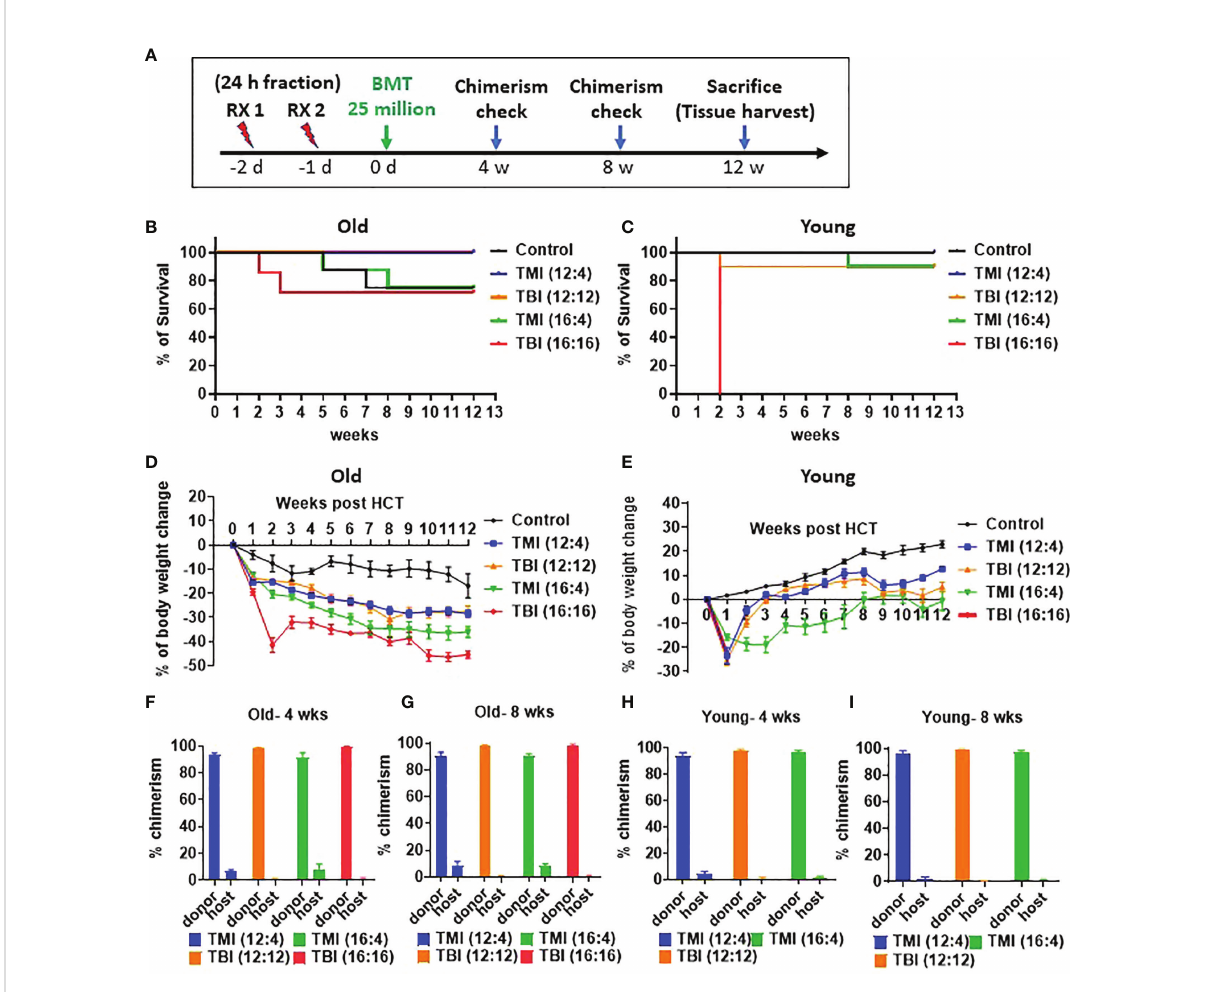
FIGURE 2 Comparison of TMI vs. TBI in survival, and donor engraftment in old and young mice. (A) Experiment schema. A total of 25 million of whole bone marrow cells were injected at 1 day intravenously after 2 times irradiation. (B) Survival rate of old mice for 12 weeks after BMT (Old control, n=8; TMI (12:4), n=10; TBI (12:12), n=10; TMI (16:4), n=8; TBI (16:16), n=7). (C) Survival rate of young mice for 12 weeks after BMT (Young control, n=8; TMI (12:4), n=10; TBI (12:12), n=10; TMI (16:4), n=10; TBI (16:16), n=10). (D) Body weight changes of old mice for 12 weeks after Rx/BMT. Mean ±SEM value. P- value are shown in Supplementary Figure S2 and body weight changes of individual mice were shown in Supplementary Figure 4A. (E) Body weight changes of young mice for 12 weeks after Rx/BMT. Mean ±SEM value. P-value are shown in Supplementary Figure S3 and body weight changes of individual mice were shown in Supplementary Figure 4B. (F, G) Donor engraftment of peripheral blood in old mice at 4 weeks and 8 weeks after Rx/ BMT. Donor: CD45.1, Host: CD45.2. (H, I) Donor engraftment of peripheral blood in young mice at 4 weeks and 8 weeks after Rx/BMT. Donor: CD45.1, Host: CD45.2. Data represent the mean±SEM, unpaired t test, Two-way ANOVA test, Log-rank Mantel-Cox